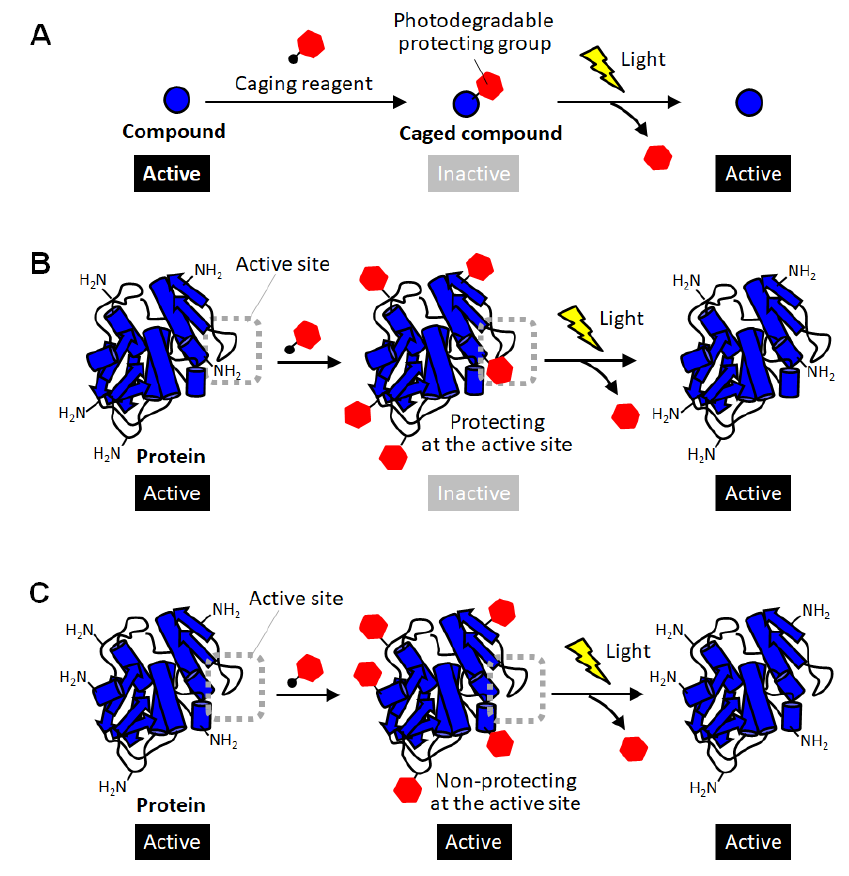
Figure 1. Schematic illustration of caging of compounds and proteins. ( A ) Caging of small molecular compounds. ( B ) Successful and ( C ) unsuccessful caging of proteins through random modification of lysine residues.